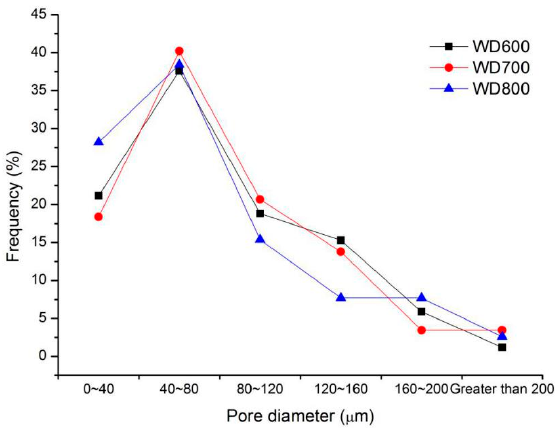
Figure 4. Pore size distribution of the air-void structure of series I mixtures.